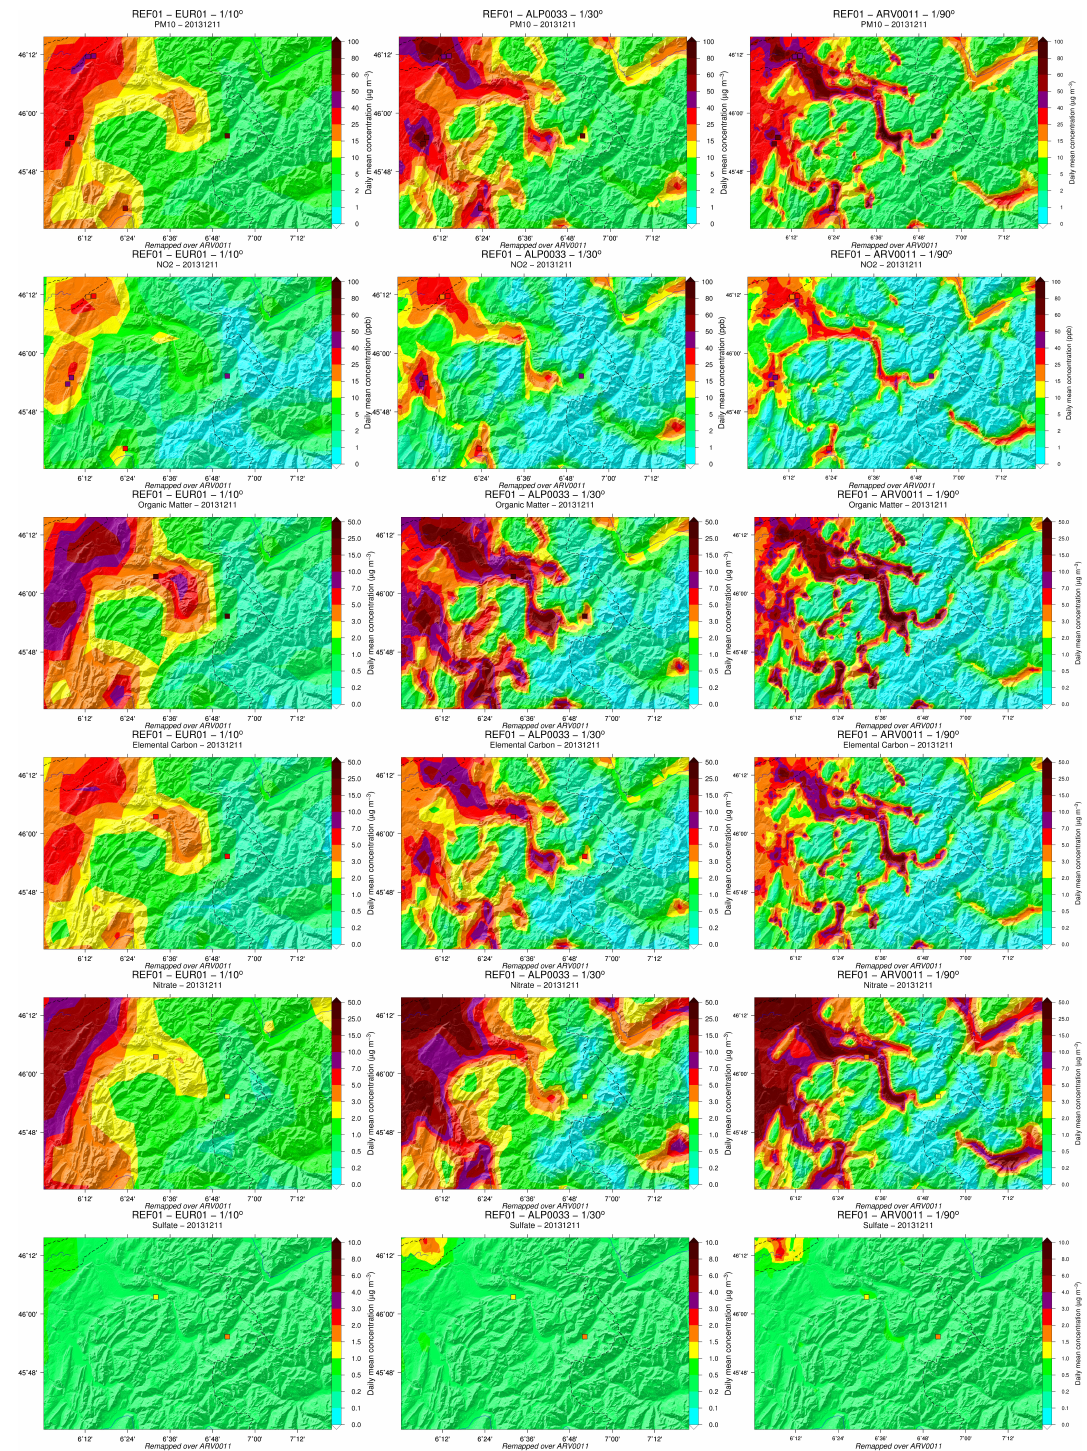
Figure 5. Impact of the horizontal resolution 1/10 ◦ –1/30 ◦ –1/90 ◦ (from left to right) on daily concentration fields on 11 December 2013 for six pollutants and species (PM10, NO 2 , OM, EC, Nitrate, Sulfate from top to bottom) over the Arve Valley domain (ARV0011). Colored squares represent the